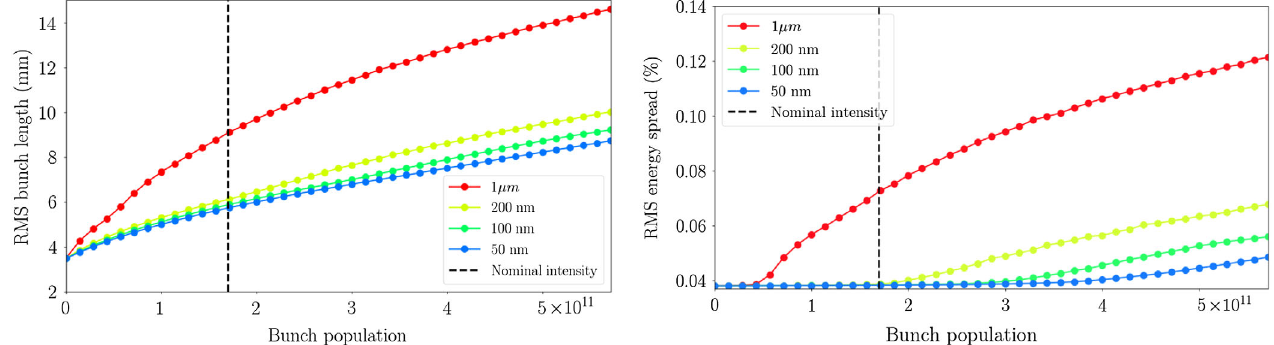
FIG. 4. RMS bunch length (left side) and RMS energy spread (right side) as a function of the bunch population given by numerical simulations considering only the RW impedance produced by NEG films with different thicknesses. The dashed black line corresponds to the nominal bunch